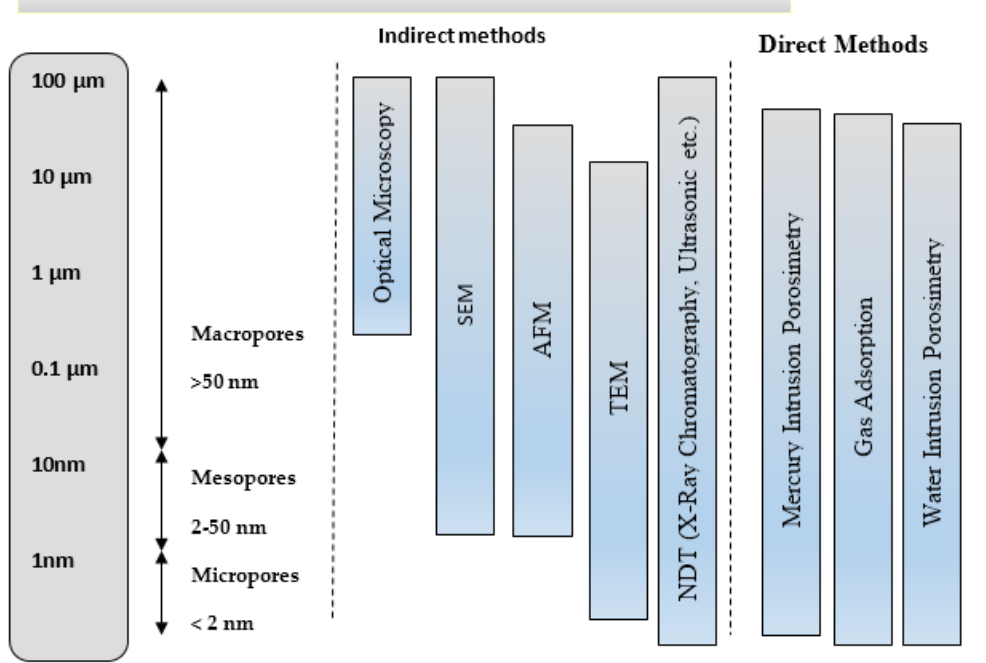
Figure 3. Porosity characterization techniques.